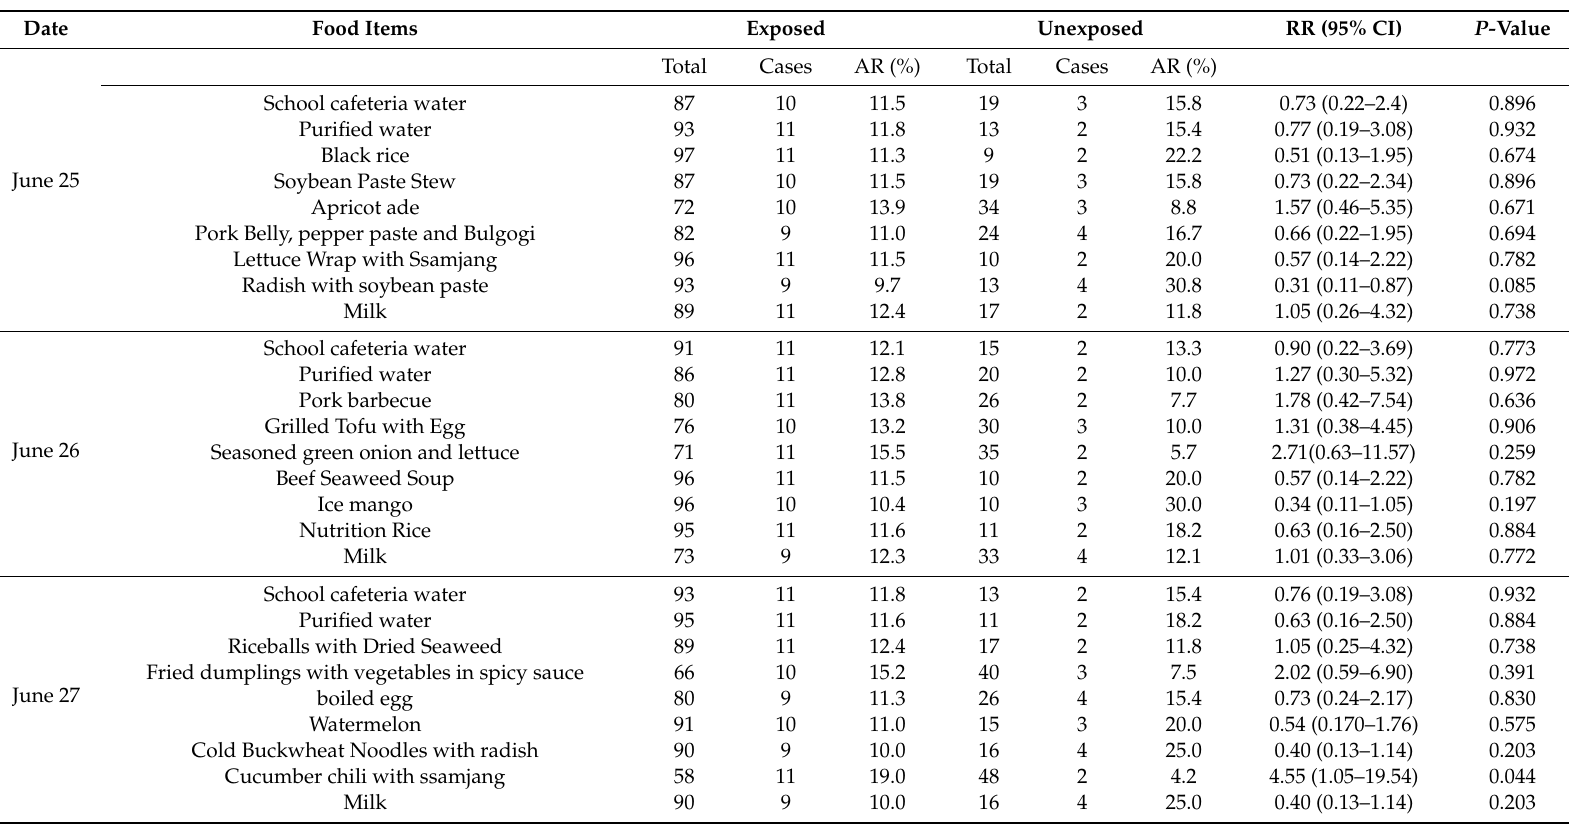
Table 2. Univariate analysis of water-contaminated foodstu ff exposure associated with the diarrhoeagenic enteropathogenic Escherichia coli ( EPEC ) infection